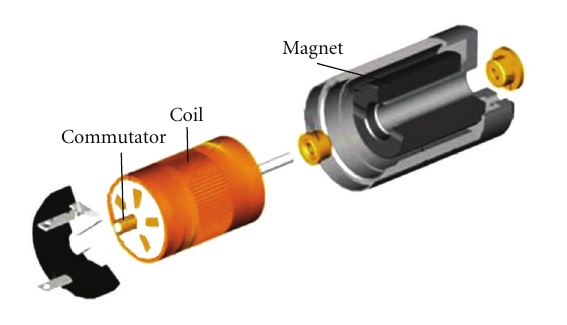
Figure 16: Coreless motor structure, from